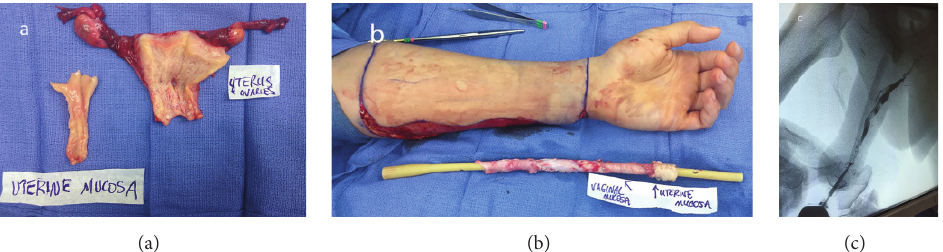
Figure 1: (a) Uterus and ovaries following hysterectomy and oophorectomy with portion of uterine mucosa resected for prelamination; (b) uterine and vaginal mucosa lining Foley catheter for prelamination of radial forearm flap; (c) retrograde cystourethrogram demonstrating patent